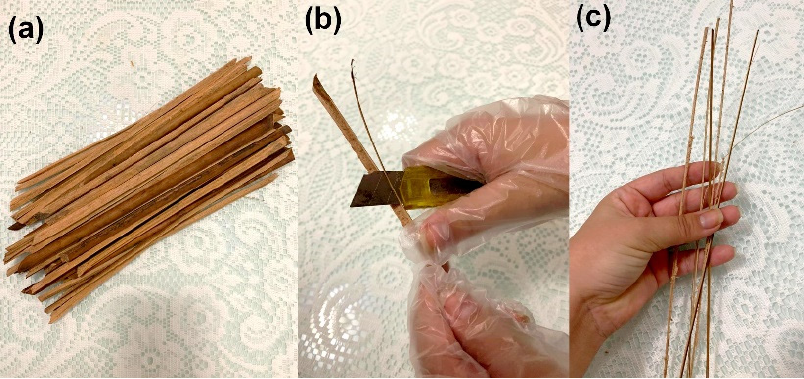
Figure 1. Processing of caranan fiber: ( a ) leafstalk, ( b ) mechanical separation of fibers, and ( c ) defibrillated caranan fibers.